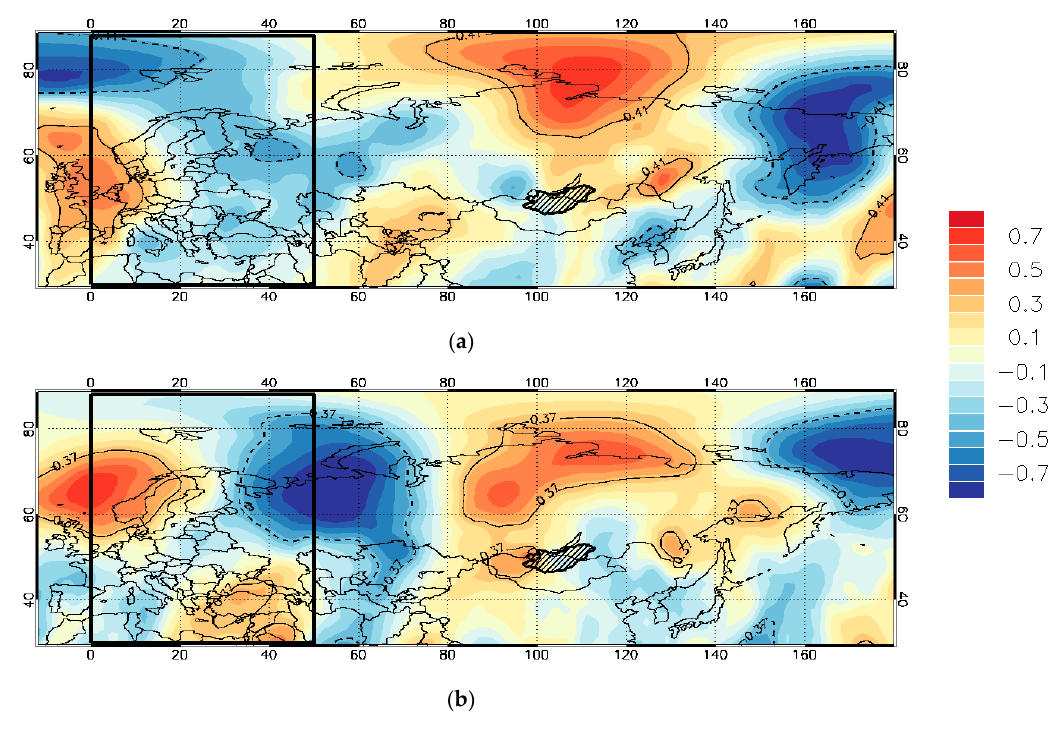
Figure 13. Correlation coefficients of E-BF and v-component of wind at 250 hPa (V250) for 1979–1995 ( a ) and 1996–2016 ( b ). The description is the same as in Figure 8.